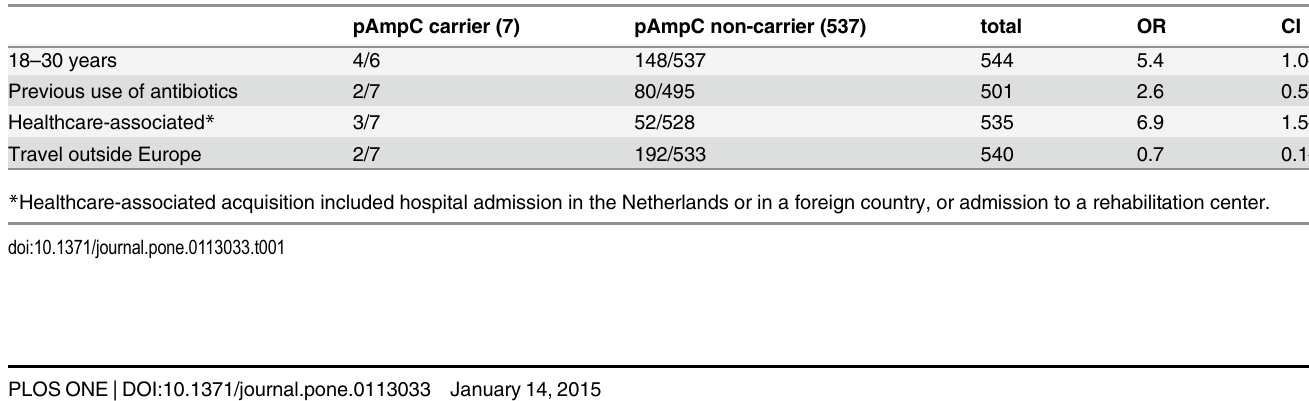
Table 1. Characteristics of the participants (n = 544)